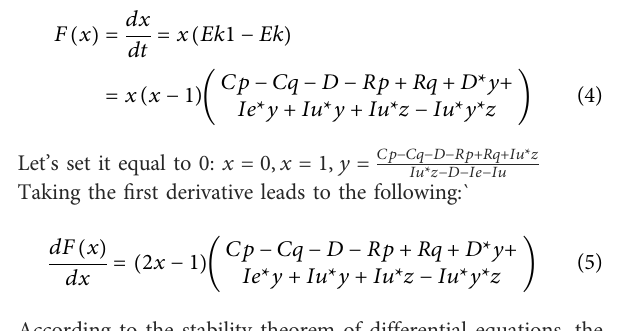
(cid:6)(cid:6)(cid:6)(cid:6) > 0 dx x (cid:2) 1